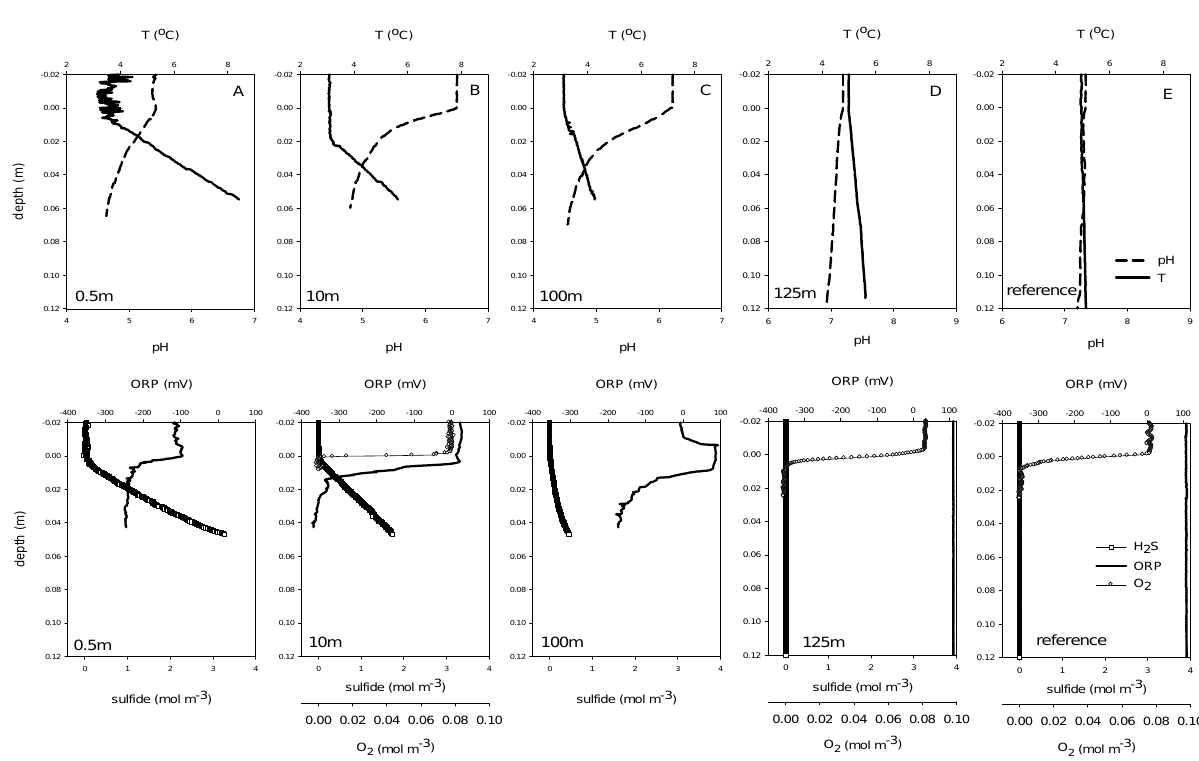
Fig. 2. In situ microprofiles of oxygen, pH, sulfide, ORP (redox potential) and temperature, measured during two cruises in 2008 (a–c) and in 2010 (d) and (e) , at different distances to Abyss Vent. The distances are indicated in the plots; the reference was taken approximately 1km southwest of the vents. The positions can be found in Table 1. All gradients clearly increase towards the vent.